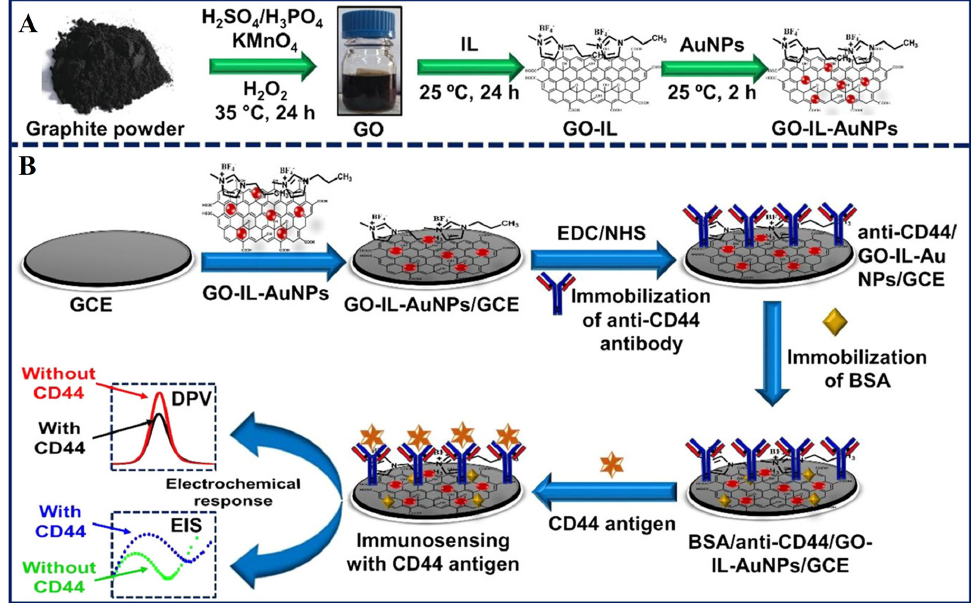
Figure 2. ( A ) Schematic diagram shows the synthesis of GO-IL-AuNPs hybrid nanocomposite and ( B ) Stepwise fabrication shows the surface modification procedures for the fabrication of BSA/anti- CD44/GO-IL-AuNPs/GCE Immunosensor. Reprinted with permission from Ref. [35] Copyright 2022,